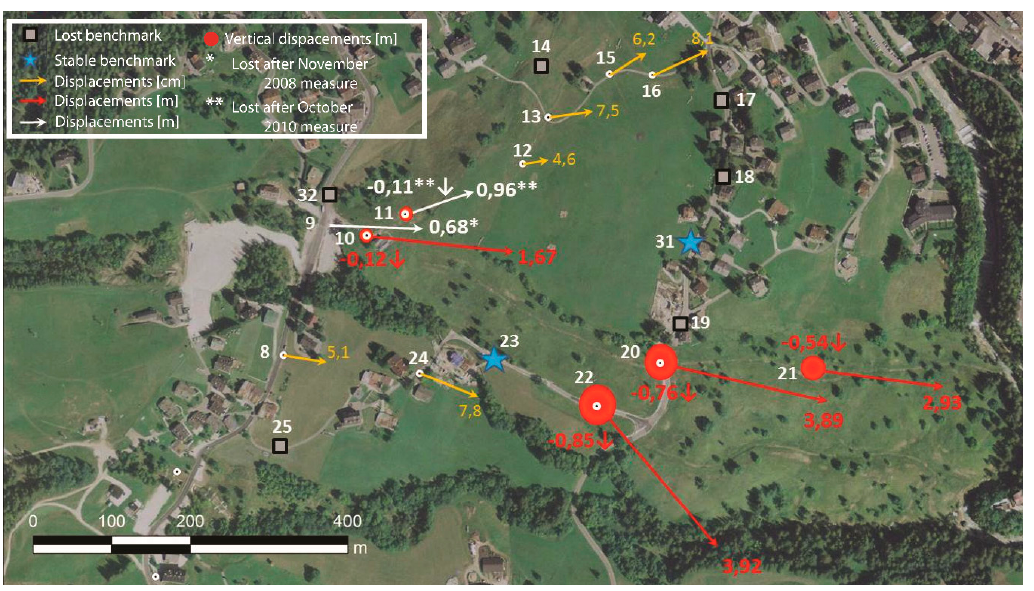
Figure 6. Horizontal and vertical displacements recorded in the lowest part of the landslide unit.